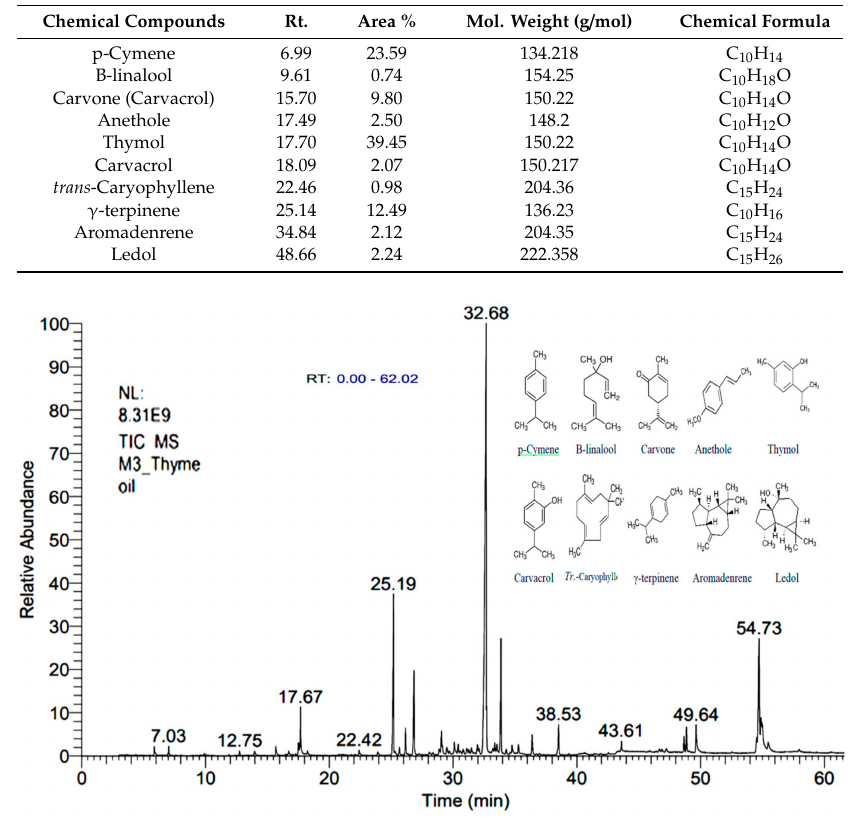
Figure 2. Retention time, area percent (%) and formulae of the major chemical compounds of essential oils of thyme as detected by the gas chromatography-mass spectrometry